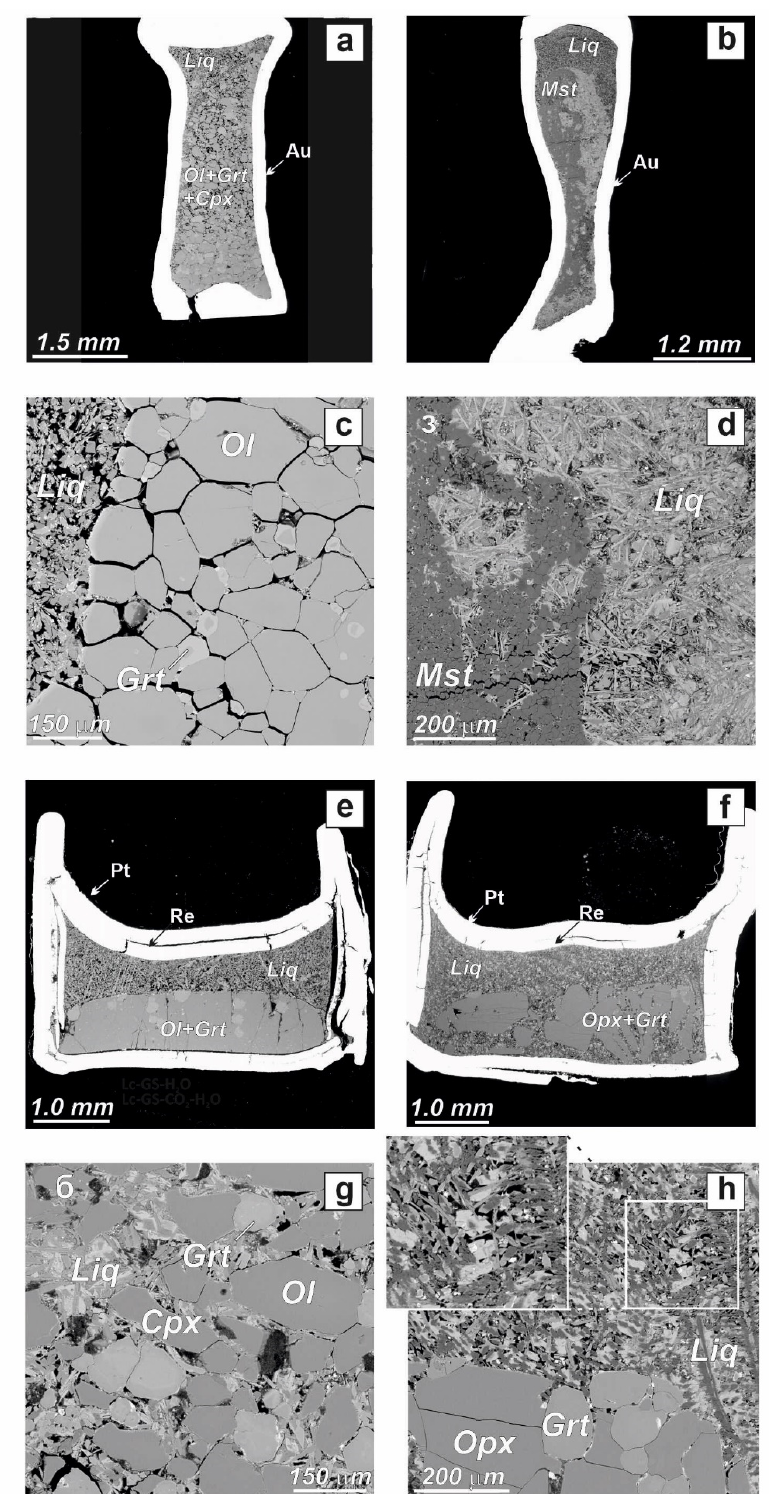
Figure 2. Backscatter electron images of representative run products in the lherzolite–carbonatite GS (Lc-GS) system. ( a , c ): No. 2200_2_6 (T = 1200 ◦ C; Lc-GS with added H 2 O); ( b , d ): No. 2200_2_4 (T = 1200 ◦ C; Lc-GS with added CO 2 and H 2 O); ( e , g ): 2192_2_4 (T = 1350 ◦ C; Lc-GS with added H 2 O); ( f , h ): No. 2190_2_2 (T = 1350 ◦ C; Lc-GS with added CO 2 and H 2 O). Insets show microcavities between dendritic crystals. Ol = olivine; Cpx = clinopyroxene; other abbreviations are as in Figure